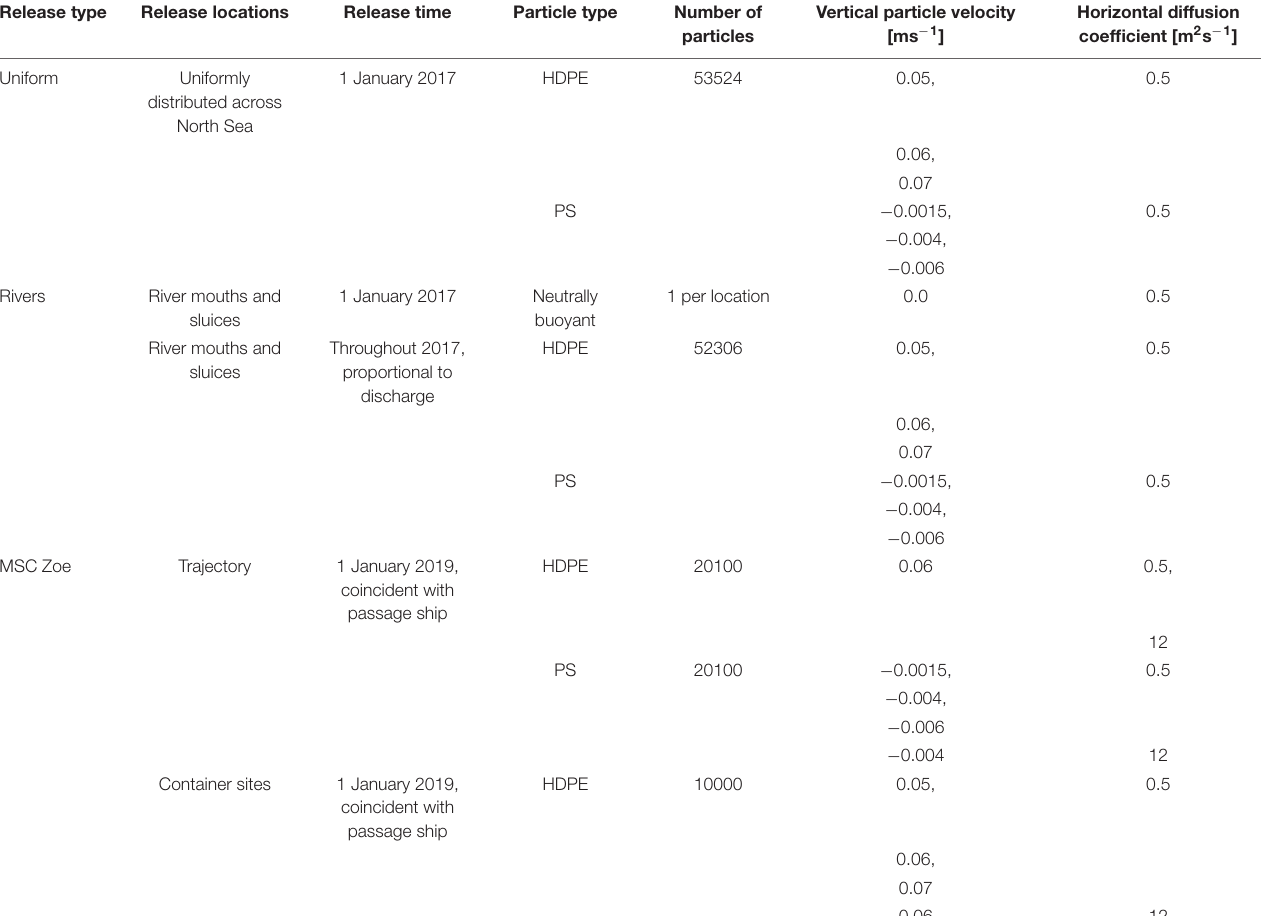
TABLE 2 | Overview of model